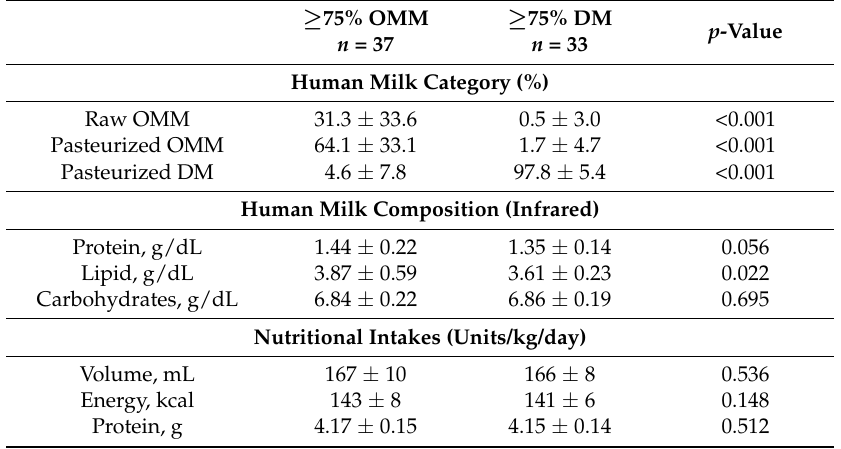
Table 2. Human milk composition and nutritional intakes during study in the two